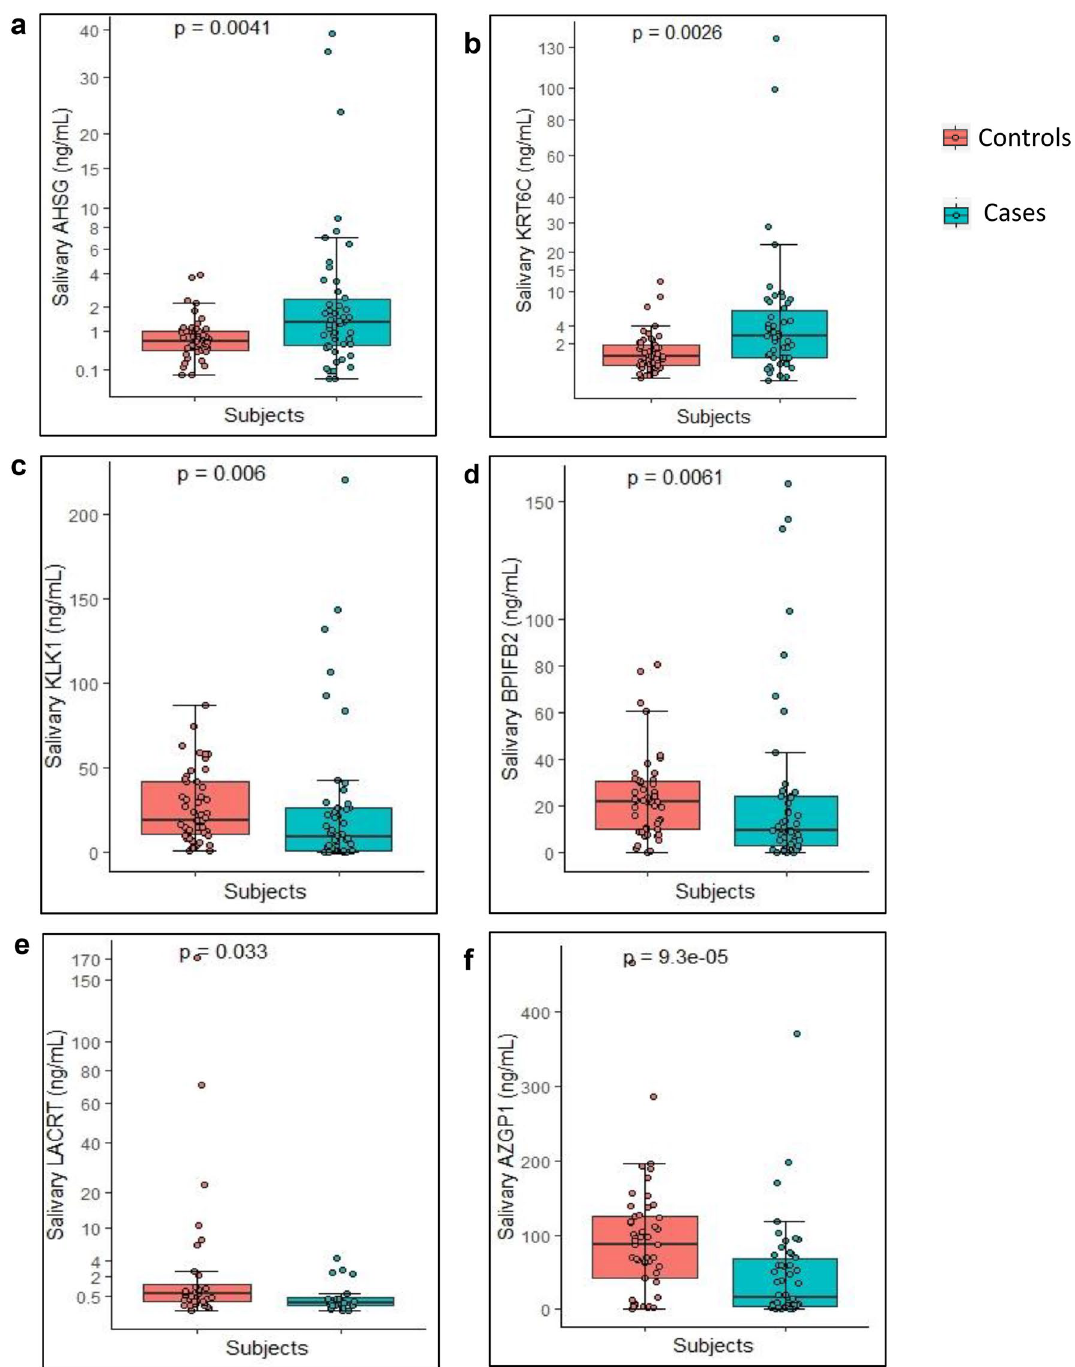
Figure 1. Levels of significantly dysregulated proteins in OSCC. Boxplot representing the levels of dysregulated proteins which were found to be significantly different between OSCC cases (n = 50) and healthy controls (n = 49) (Each dot represents individual value). Proteins ( a ) AHSG and ( b ) KRT6C were significantly upregulated with p value of 0.0041** and 0.0026 ** respectively. Proteins ( c ) KLK1, ( d ) BPIFB2, ( e ) LACRT and ( f ) AZGP1 were downregulated with p value of 0.006**, 0.0061**, 0.033* and < 0.0001***, respectively. Wilcoxon sum rank test was used to compare the median protein levels of controls and cases (p < 0.5 was the cut off for statistical significance). The levels of the proteins are represented in Table